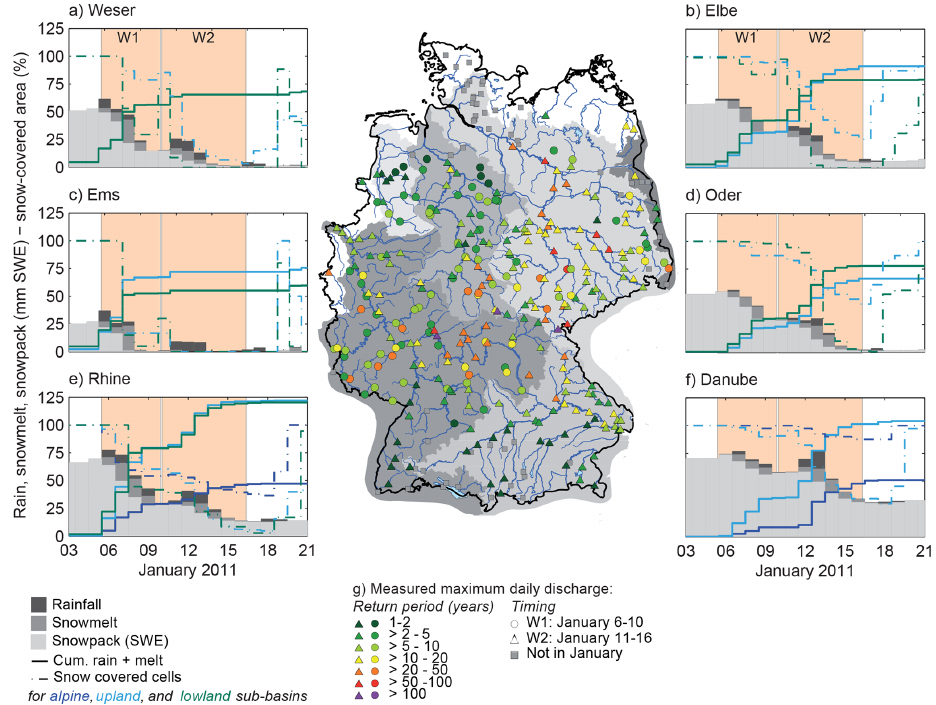
Figure 2. Large-scale analysis of the RoS event of January 2011. (a–f) Mean basin-wide daily snowpack, rainfall, and snowmelt (mm SWE) from 1 to 31 January, as well as the percentage of snow-covered cells. Map: return period and occurrence period of the maximum daily discharge in the calender year 2011 at all gauging stations (modified from Kohn et al.,